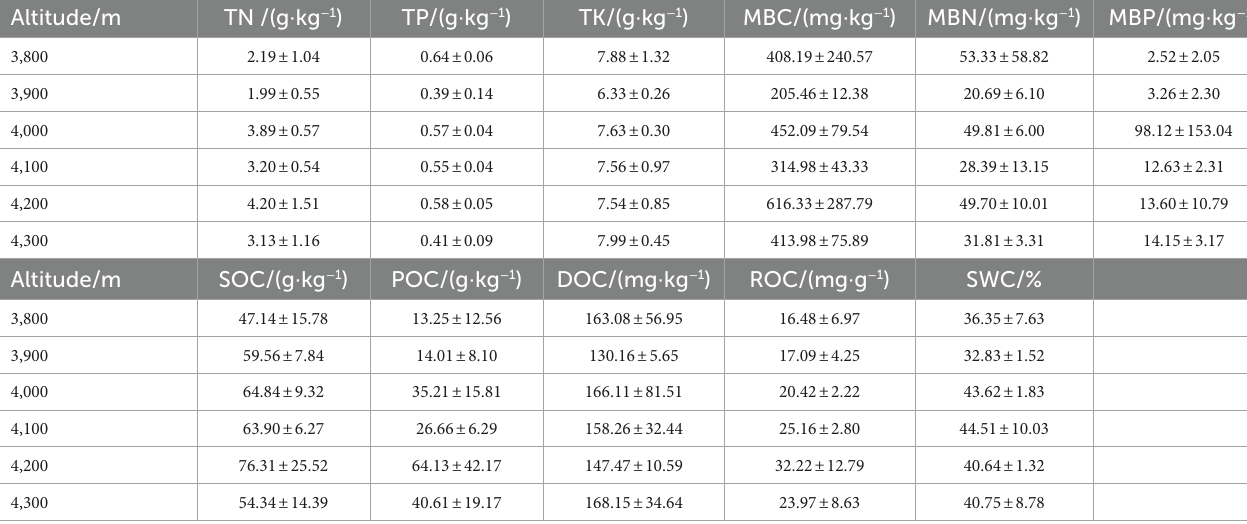
TABLE 3 Statistics of soil properties at different altitudes.